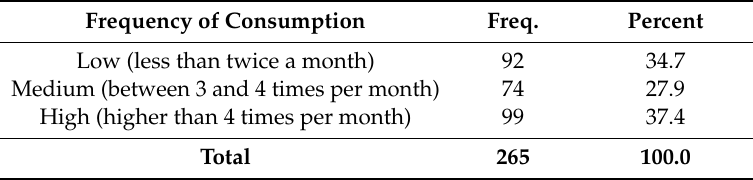
Table 3. Distribution of the three categories of the dependent variable.